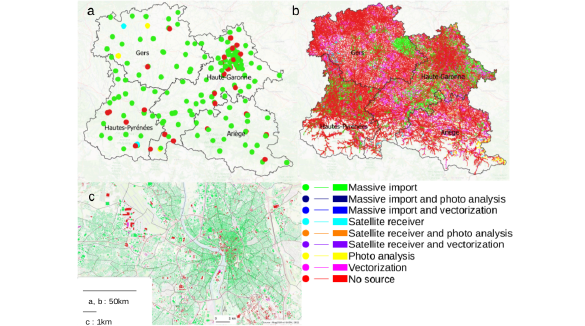
Figure 2. Spatial repartition of the different types of sources for the ”POI”, ”roads”, and ”buildings” datasets